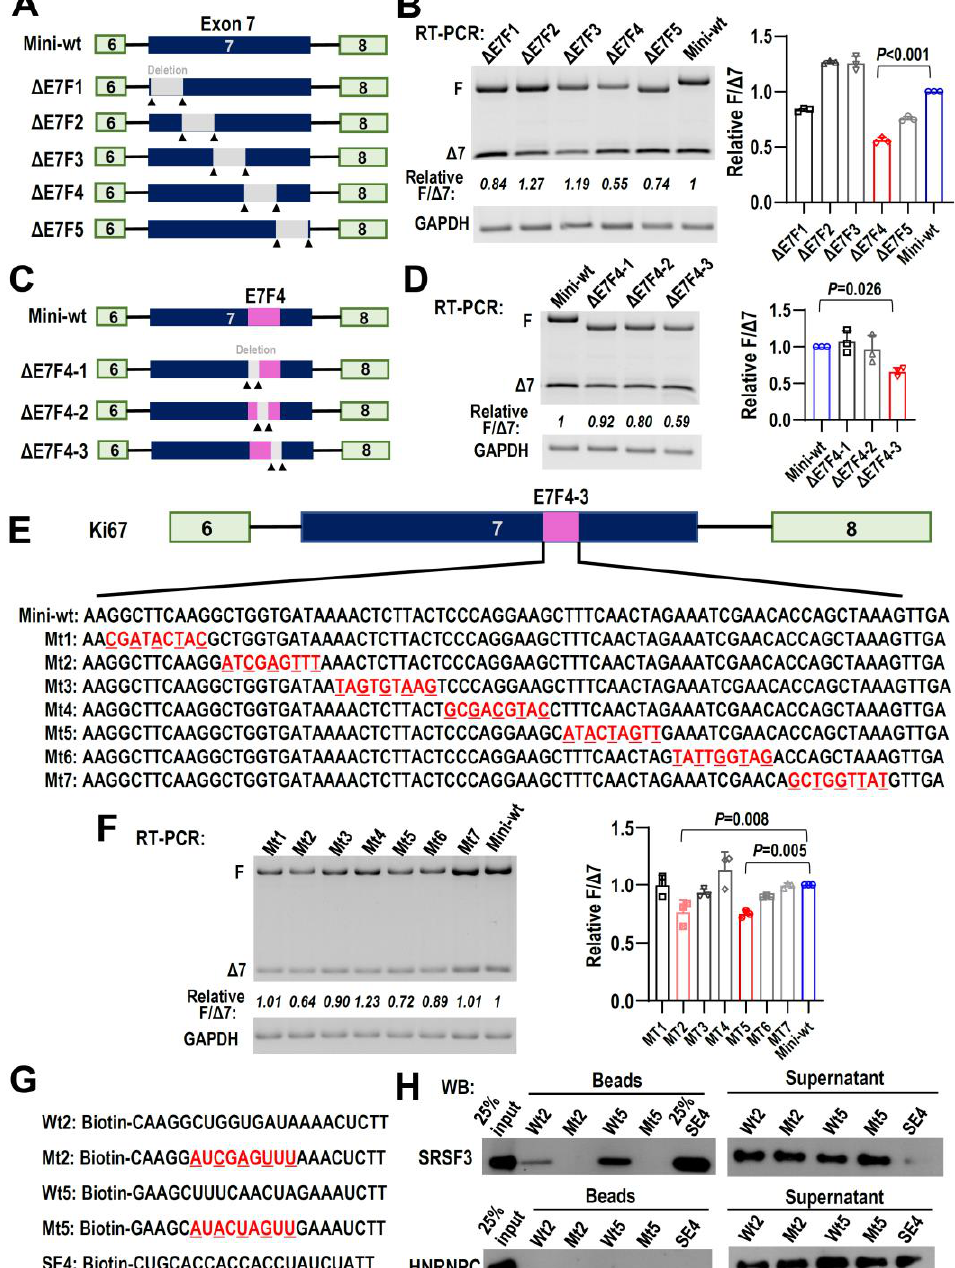
Figure 6. Splicing factor SRSF3 interacts with motifs in Ki67 exon 7. ( A ) Schematic diagrams of Ki67 exon 7 minigene and deletion positions in exon 7. The boxes represent exons and lines represent introns. ( B ) Five truncated minigenes Δ E7F1 to Δ E7F5 were transfected into CAL 27 cells. The alternative splicing of Ki67 exon 7 was analyzed by RT-PCR. ( C ) Schematic diagrams of Ki67 exon 7 minigene and deletion positions in fragment E7F4. ( D ) Three truncated minigenes Δ E7F4-1 to Δ E7F4-3 were transfected into CAL 27 cells. The alternative splicing of Ki67 exon 7 was analyzed by RT-PCR. ( E,F ) Point mutations in E7F4-3 region were constructed and mutated minigenes MT1 to MT7 were transfected into CAL 27 cells. The alternative splicing of Ki67 exon 7 was analyzed by RT-PCR. All the histograms display the statistical analysis. All data are mean ± SD, n = 3. ( G ) Biotinylated oligo RNAs were synthesized to perform the RNA pull-down assay, including wild-type (wt2 and wt5), mutant motifs (mt2 and mt5), and SE4 served as an SRSF3 positive binding control. ( H )